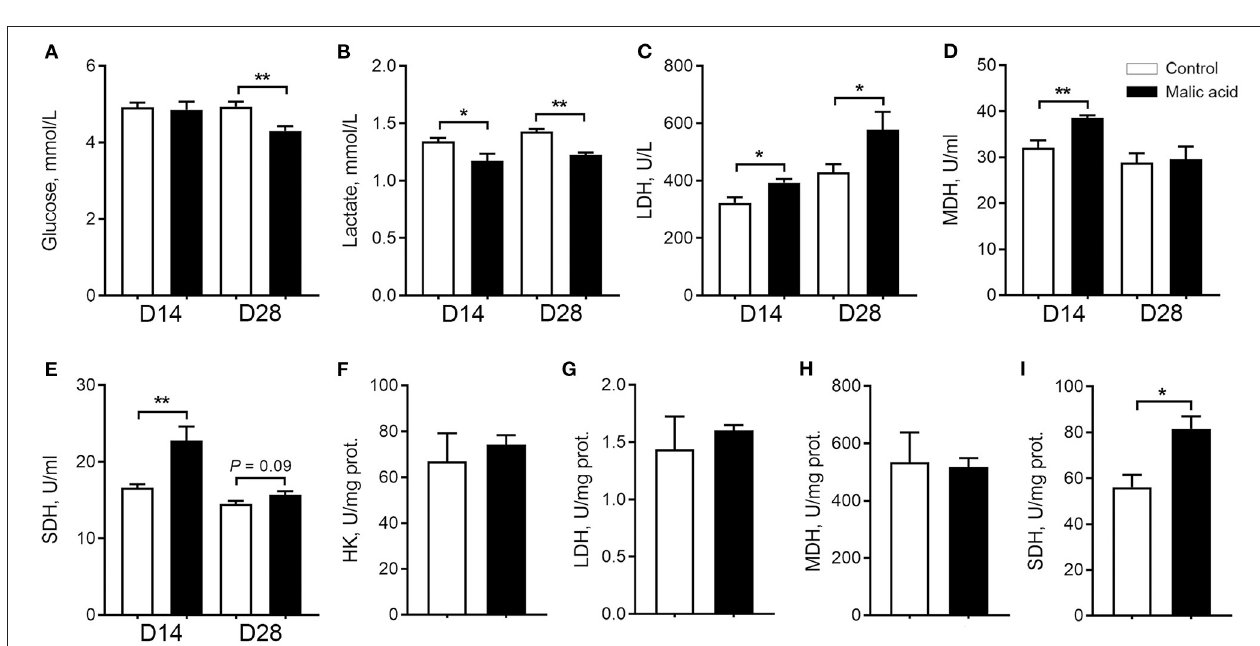
FIGURE 1 | Effect of dietary malic acid supplementation on metabolic characteristics of weaned piglets. (A,B) Effects of malic acid on glucose and lactate levels in serum. (C–E) Effects of malic on LDH, MDH, and SDH activities in serum. (F–I) Effects of malic acid on activities of HK, LDH, MDH and SDH in skeletal muscle. D14 and D28 represented serum were collected on days 14 and 28 of the experiment. Data were presented as means ± SEM ( n = 6). The statistical significance of difference between two means was calculated using t -test. * p < 0.05, ** p < 0.01.